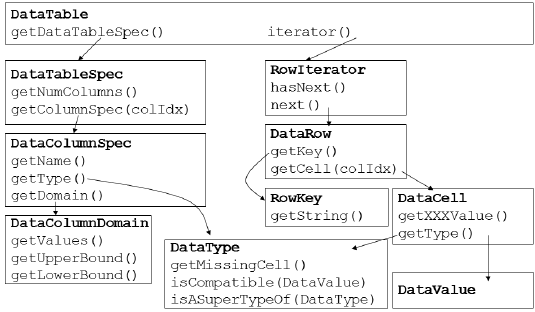
Fig. 6. A schematic showing how data tables can be ac- cessed in KNIME.